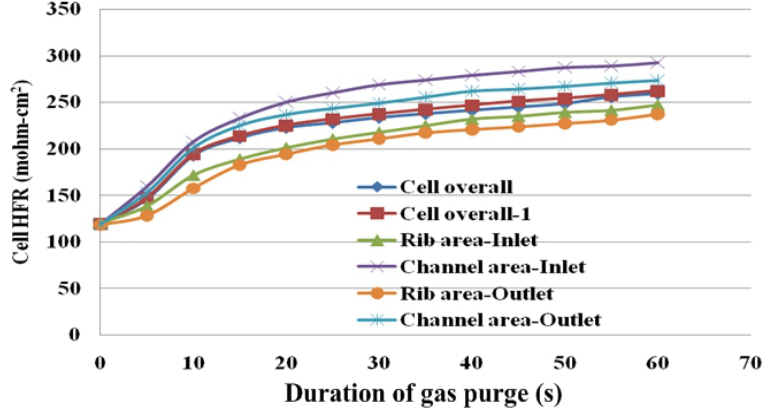
Figure 11. Local HFR variations at flow rate of 4